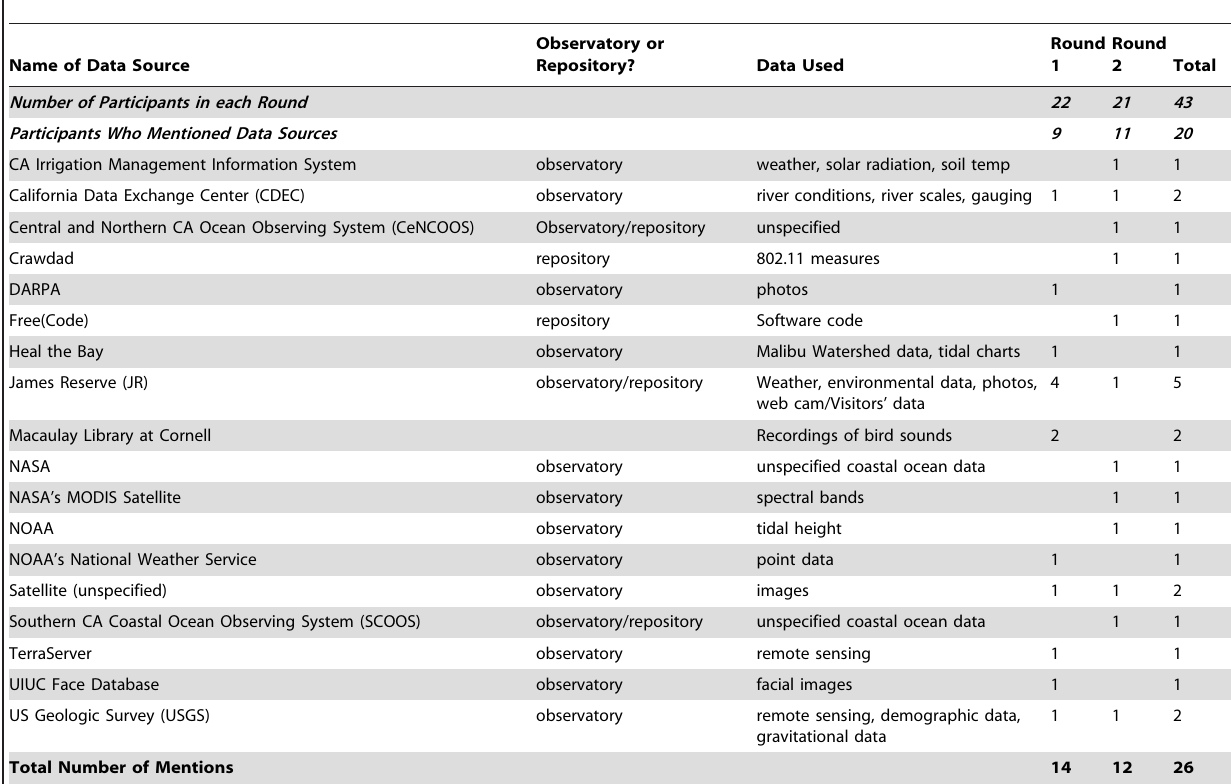
Table 5. Where researchers find data for reuse and what data they